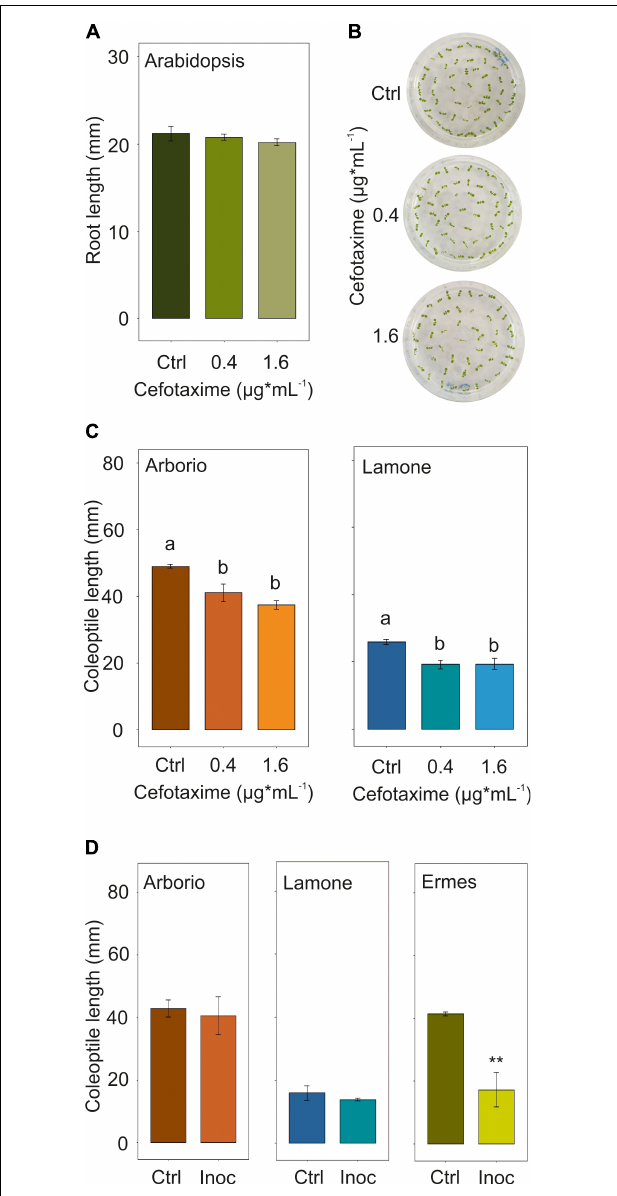
FIGURE 2 | (A) Arabidopsis root growth up to 7 days after germination, using cefotaxime MIC 0.4 ug*mL − 1 and a further concentration of 1.6 ug*mL − 1 in the medium. Data are the mean ± SD ( n = 3). ANOVA test. (B) Arabidopsis seedling phenotype at day 7 after germination using cefotaxime MIC 0.4 ug*mL - 1 and a further concentration of 1.6 ug*mL - 1 in the medium. (C) Lamone and Arborio coleoptile length at day 4 under dark submergence, adding cefotaxime MIC 0.4 ug*mL - 1 and a further concentration of 1.6 ug*mL - 1 in the medium. Data are the mean ± SD ( n = 3). ANOVA test p < 0.05. Tuckey post hoc test (D) Lamone, Arborio and Ermes coleoptile length at day 4 under dark submergence, inoculating the seed with bacteria suspension. Data are the mean ± SD ( n = 3). Student’s t -test, p ≤ 0.01.